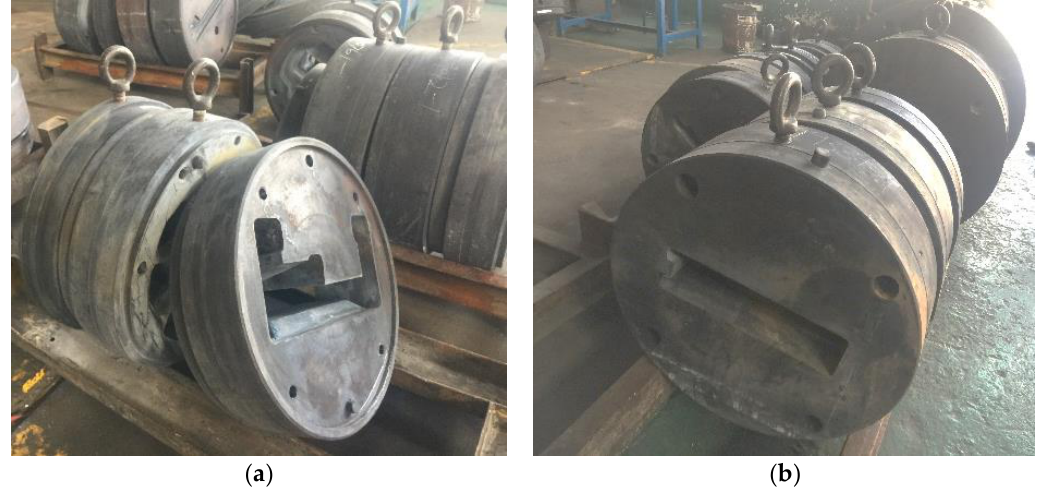
Figure 4. Extrusion dies with customised holes for different aluminium profiles ( a ) and ( b ).